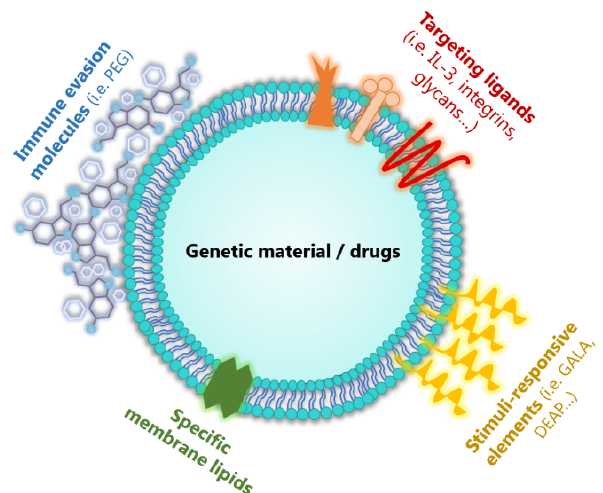
Figure 4. Structure of an ideal extracellular vesicle ( EV ) for drug delivery. EVs can be artificially synthetized or engineered to gain potential as ideal Drug Delivery Systems (DDS). While maintaining their natural membrane or synthetizing a simple liposome, immunosuppressive molecules (such as polyethylene glycol (PEG)) could be added to the membrane to avoid the action of the immune system of the patient. Moreover, different targeted ligands (like IL-3, integrins or glycans) could be used to direct the vesicles with the therapy to specific cells or tissues delivery. Moreover, stimuli-responsive elements (for instance pH-sensitive peptide (GALA) or 3-(diethylamino) propylamine (DEAP)) help to deliver their cargo with more specificity. Within the inner core, EVs may contain genetic material (like siRNA for therapy) of drugs against cancer or other diseases.